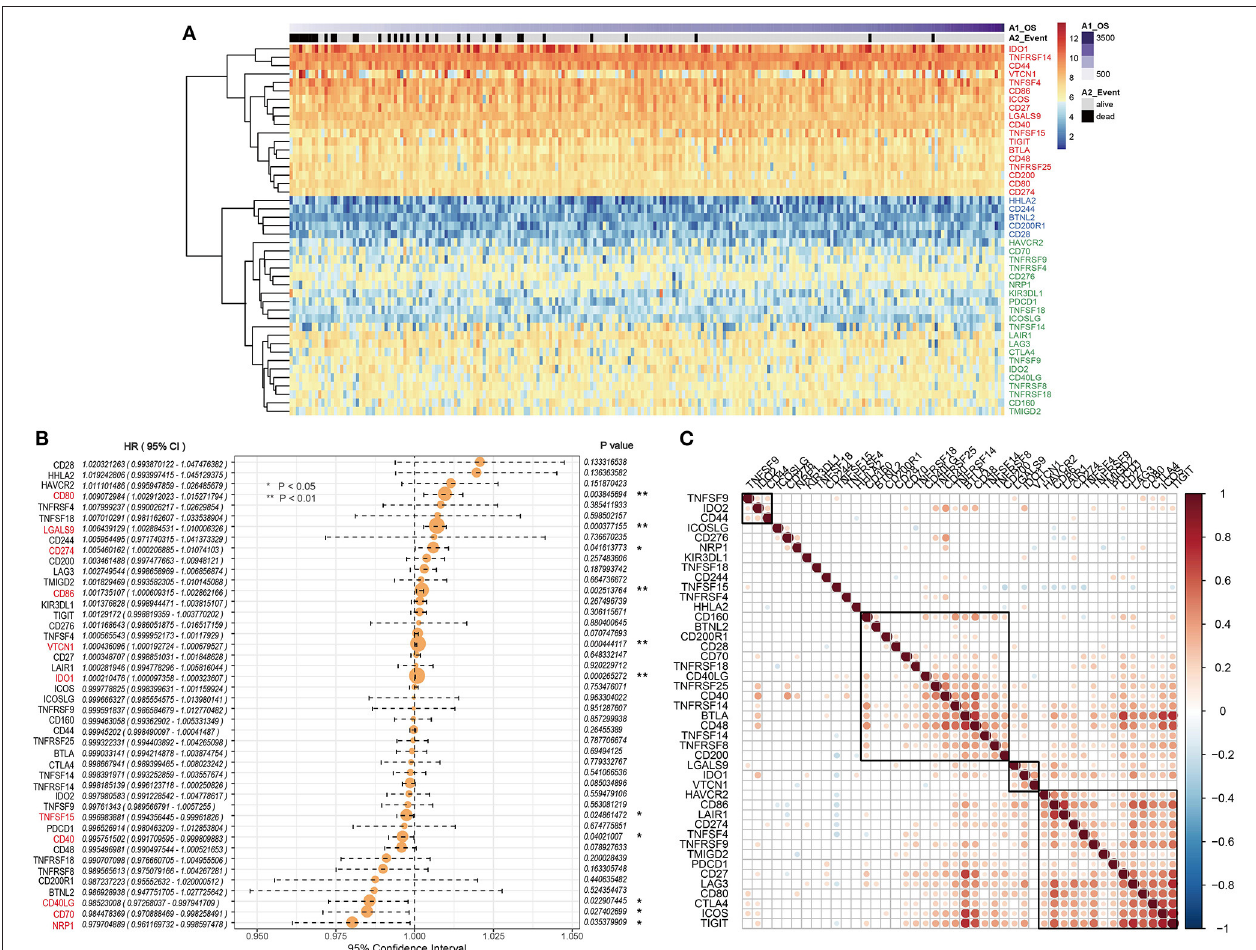
FIGURE 8 | (A) Unsupervised clustering of ICGs in the GSE31210 cohort. The overall survival and status event were used as patient annotations. Red: high expression group; green: medium expression group; blue: low expression group. (B) Relationship between ICGs expression and prognosis in forest plot. Abscissa represents 95% confidence interval, ordinate (left) represents gene, and the vertical line in the middle of P -value represents the invalid line. When the horizontal line of 95% confidence interval of a gene crosses with the invalid line, it can be considered that there is no statistical correlation between gene expression and patient survival. If the horizontal line falls to the left of the invalid line, the gene can indicate a higher likelihood of success for patient prognosis. If the horizontal line falls to the right of the invalid line, it can be considered as a risk factor for the patient survival. (C) Correlation heatmap of ICGs expression levels. Only the gene pairs with significant correlation test are shown: the blank indicates zero significance of correlation test, blue represents negative correlation, and red represents positive correlation. * P < 0.05, ** P <